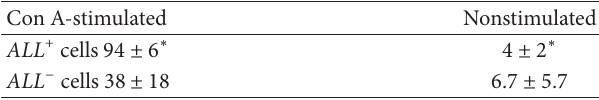
Table 2: Frequency of TGF- 𝛽 + cells on purified CD4 + cells. Con A-stimulated Nonstimulated ALL + cells 94 ± 6 ∗ 4 ± 2 ∗ ALL − cells 38 ± 18 6.7 ± 5.7 ∗ 𝑃 = 0.003